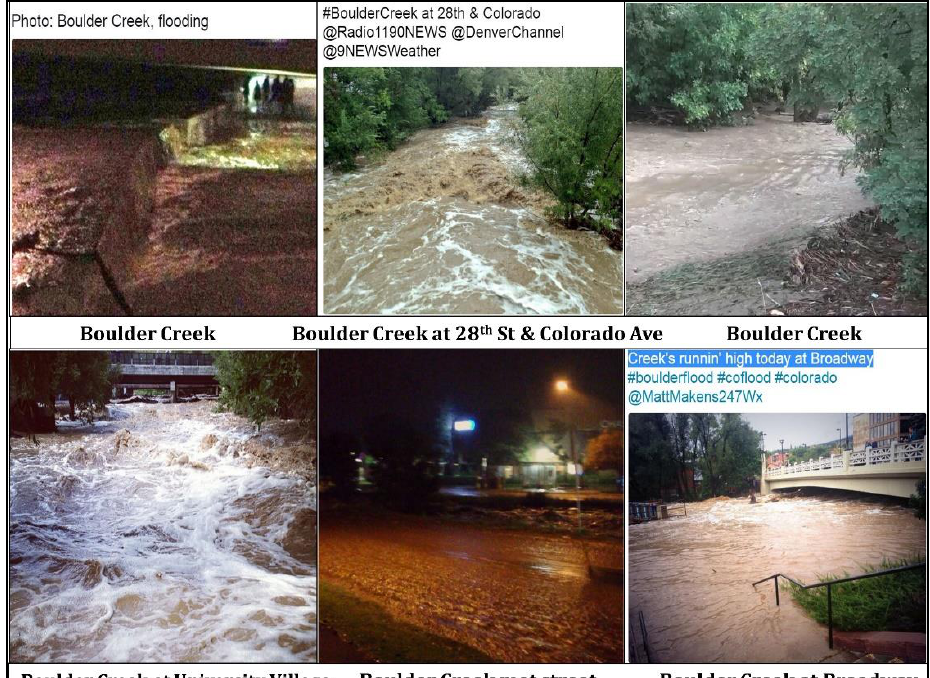
Figure 3. Images of Boulder Creek.